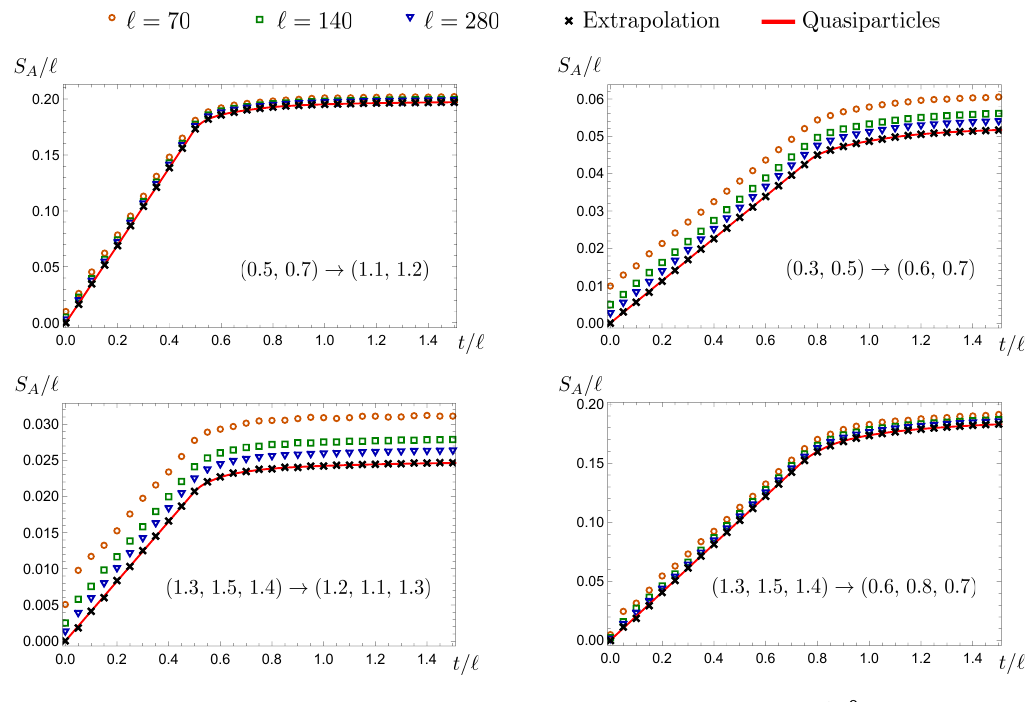
Figure 3: Entanglement entropy evolution for various quenches { h t < 0 in the inhomogeneous Ising model. We consider a bipartition A ∪ ¯ A where A = [ 1, (cid:96) ] . In each panel we plot the rescaled entanglement entropy S rescaled time t /(cid:96) . When the finite (cid:96) data are extrapolated to (cid:96) → ∞ , as explained in the text, the agreement with the quasiparticle prediction is